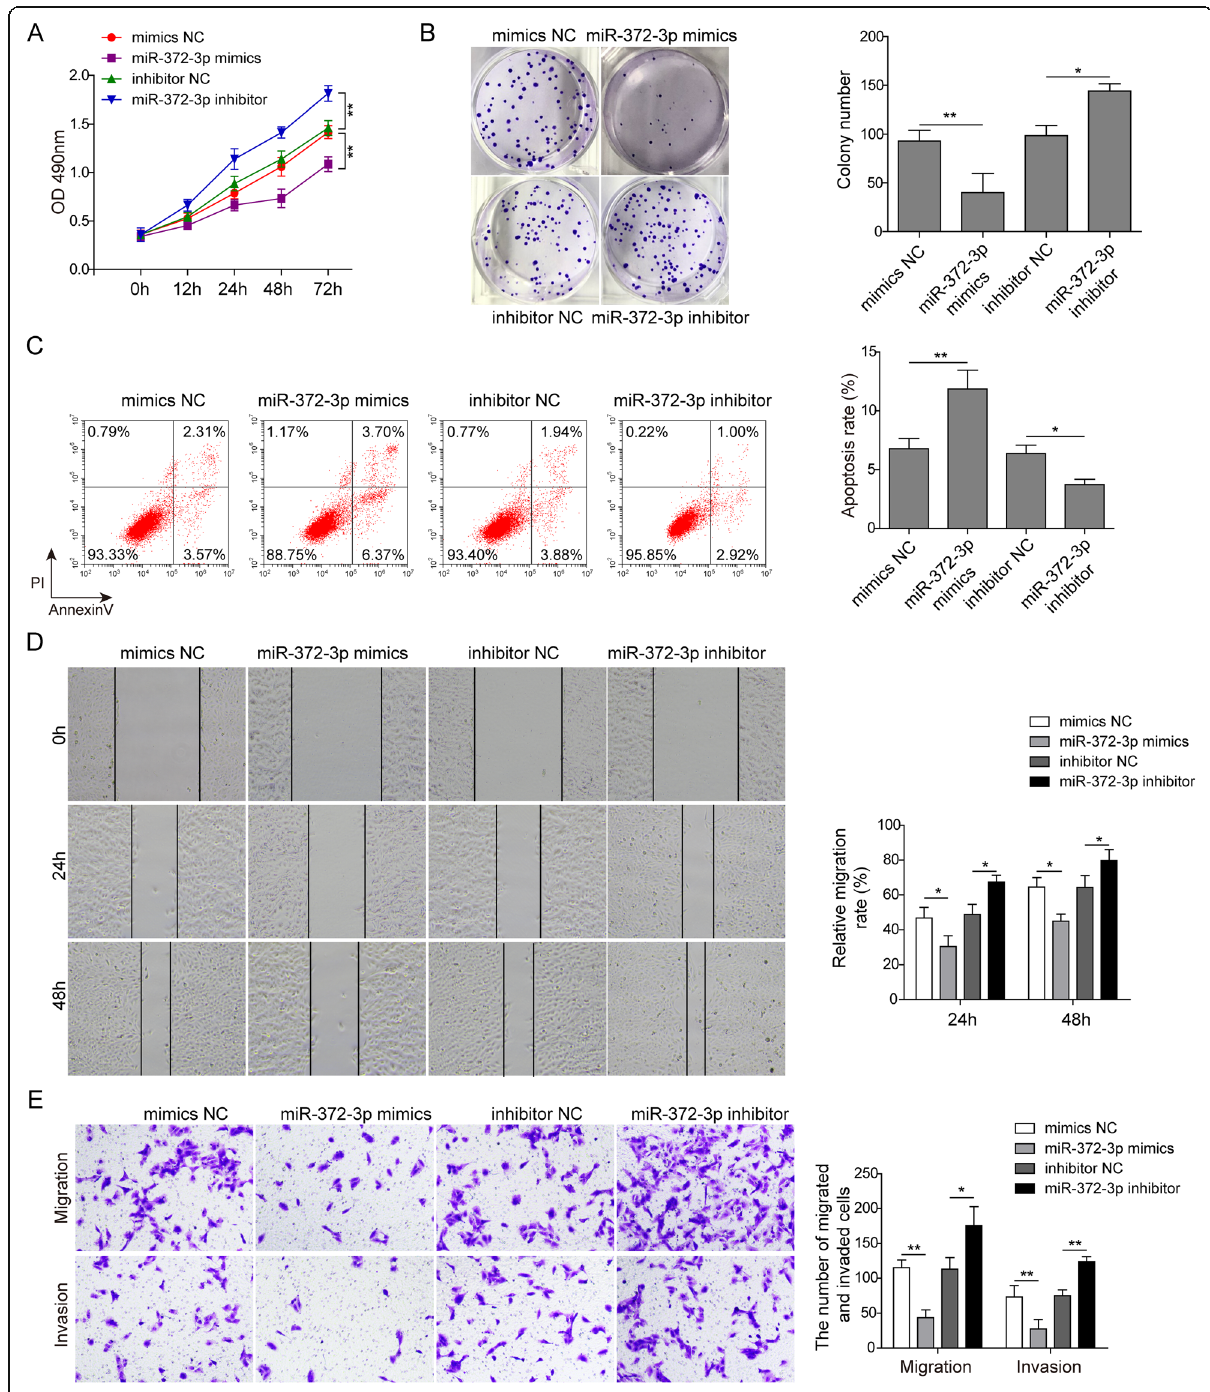
Fig. 4 miR-372-3p suppressed the proliferation, migration and invasion of osteosarcoma cells in vitro. U2OS cells were transfected with mimics NC, miR-372-3p mimics, inhibitor NC, or miR-372-3p inhibitor. Cell proliferation was tested by CCK-8 assay (A) and colony formation assay (B); cell apoptosis was analysed by flow cytometry (C); and cell migration and invasion were detected by wound healing assay (D) and transwell assay (E). Data are shown as the mean ± SD. * p < 0.05, ** p <